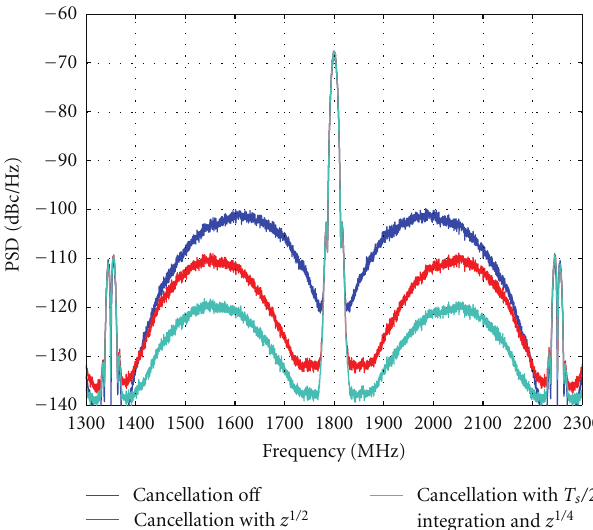
Figure 12: The simulated PSD of a GFSK-modulated signal show- ing PQN reduction with optimized cancellation signal advancement and integration time.